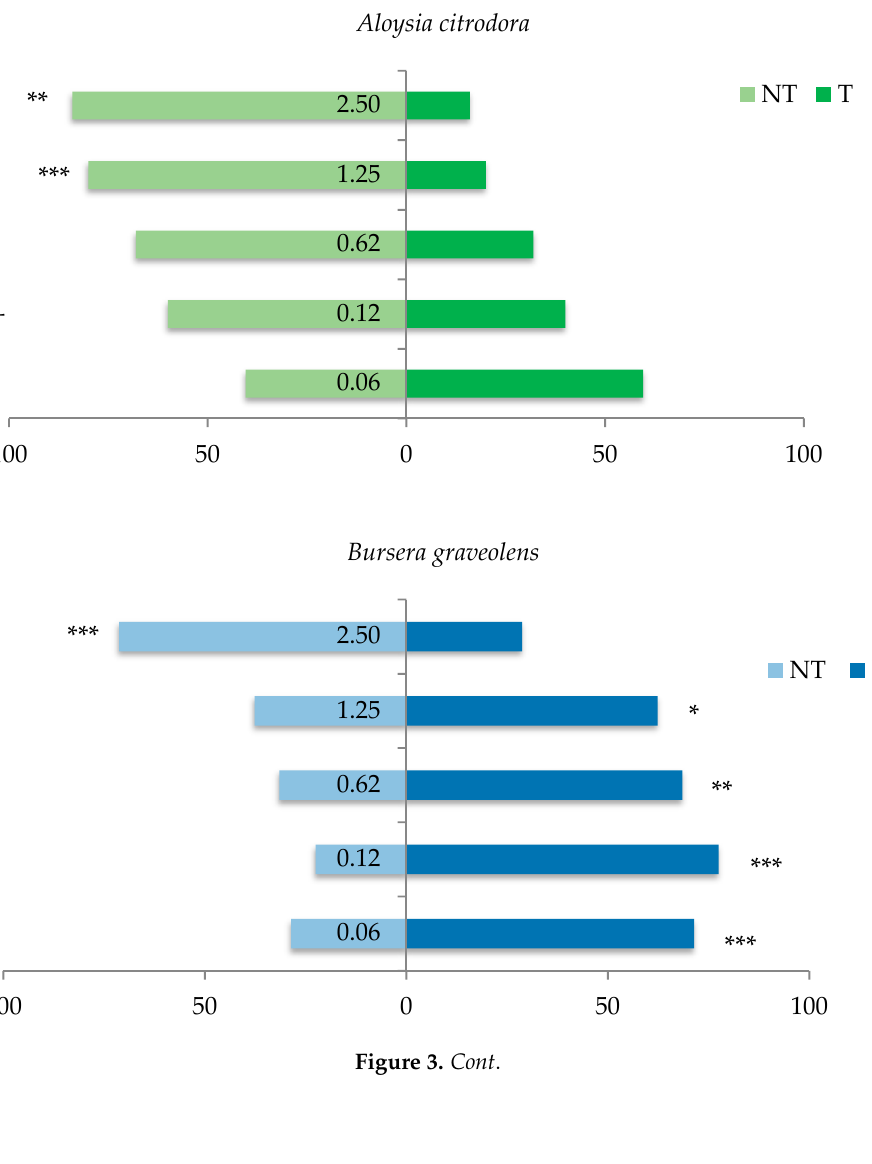
Figure 2. Specific olfactory descriptors and the percentage of times they were used by the expert panel ( n = 8) for characterising the odours of Aloysia citrodora, Bursera graveolens , and Allium sativum essential oils (EOs).